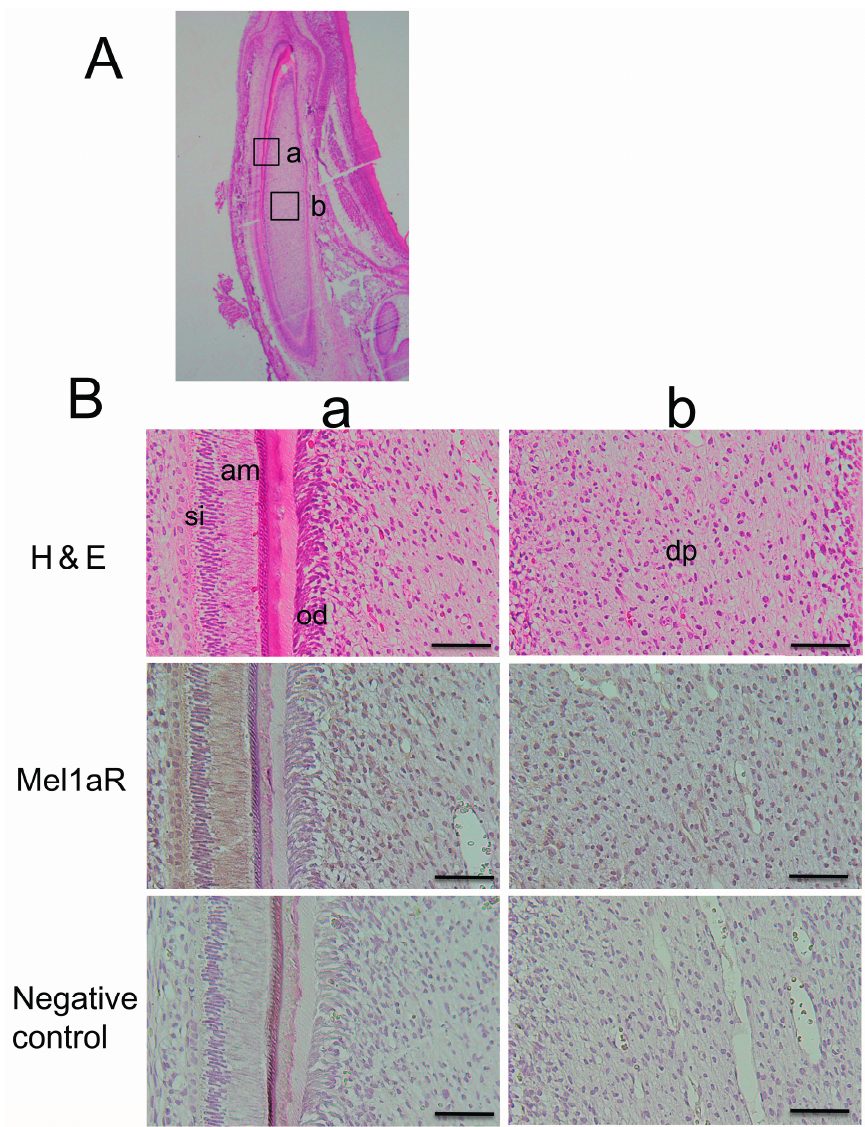
Figure 2. ( A ) Transverse section of a rat tooth germ stained with hematoxylin and eosin (H&E). Higher magnification views of several portions of the tooth germ indicated by alphabetized squares were shown in panel B; and ( B ) High magnification views of characteristic areas of the tooth germ. Mel1aR was expressed in ameloblasts (am), stratum intermedium cells (si), odontoblasts (od), dental papilla cells (dp). H&E: hematoxylin and eosin staining. Mel1aR: DAB and hematoxylin staining. Negative control: normal muse IgG. Scale bars = 25